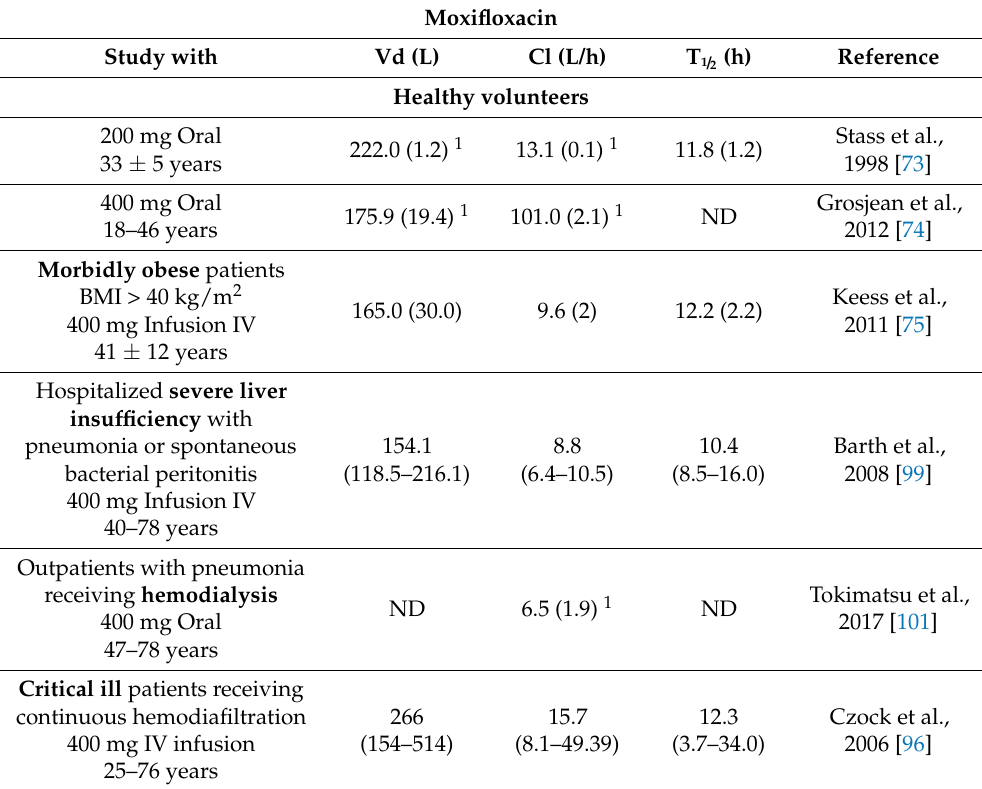
Table 3. Steady-state pharmacokinetic parameters for moxifloxacin in patients with several patho- physiologic conditions after intravenous or oral drug administration. Values expressed as mean (standard deviation) or mean (range) when standard deviation is not